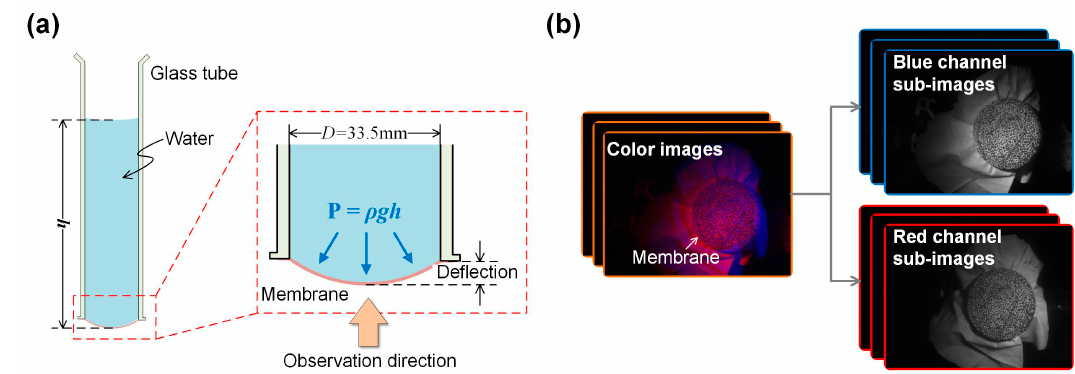
Figure 8. ( a ) Schematic of the nitrile butadiene rubber (NBR) testing device and ( b ) captured color images and separated blue and red channel sub-images.